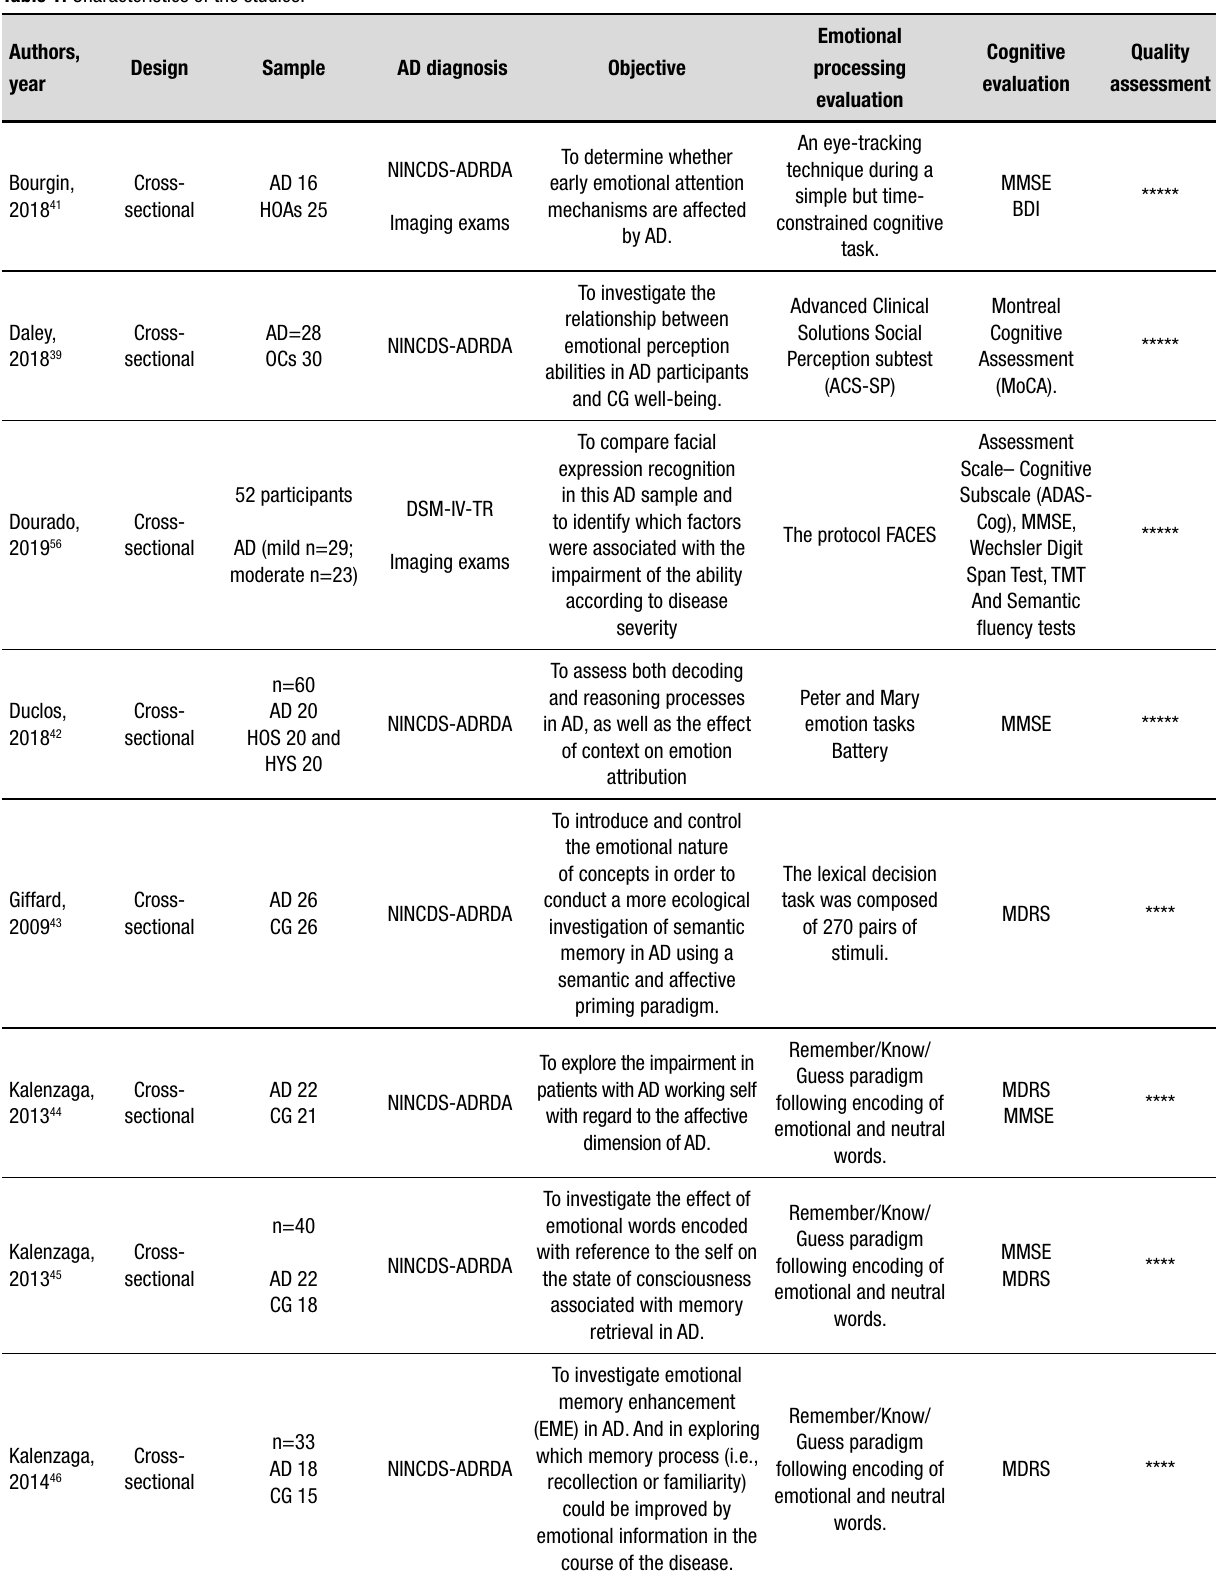
Table 1. Characteristics of the